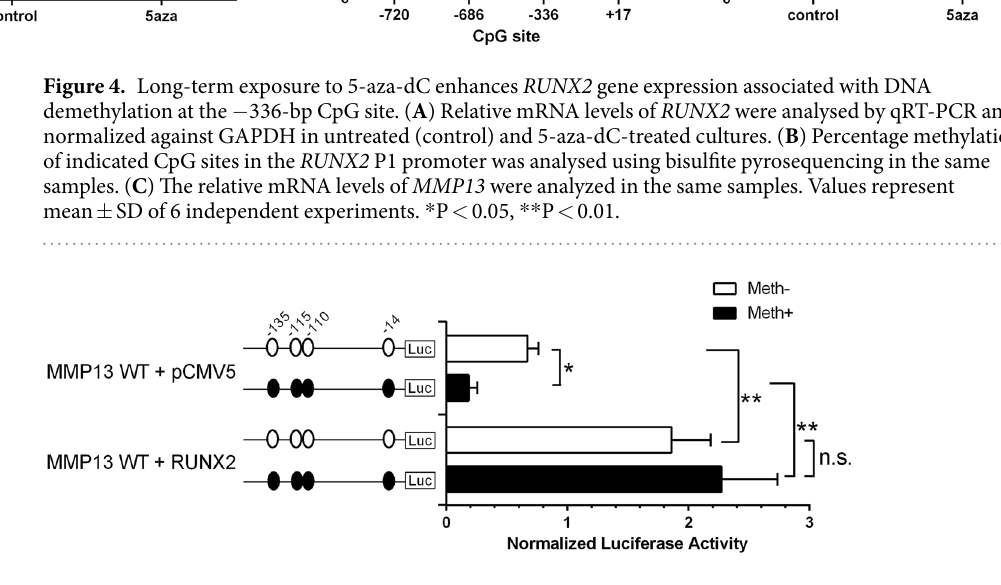
Figure 5. RUNX2-driven MMP13 promoter transactivation in chondrocytes is not impaired by CpG methylation. MMP13 promoter activity was analysed by the luciferase reporter assay after transfection of C28/ I2 cells with non-methylated or methylated constructs in a CpG-free reporter vector containing the wild-type MMP13 promoter. Co-transfection with the pCMV-RUNX2 expression vector or the empty control vector (pCMV5) was performed. Values are the mean ± SD of 4 independent experiments. * P < 0.05, ** P < 0.01.